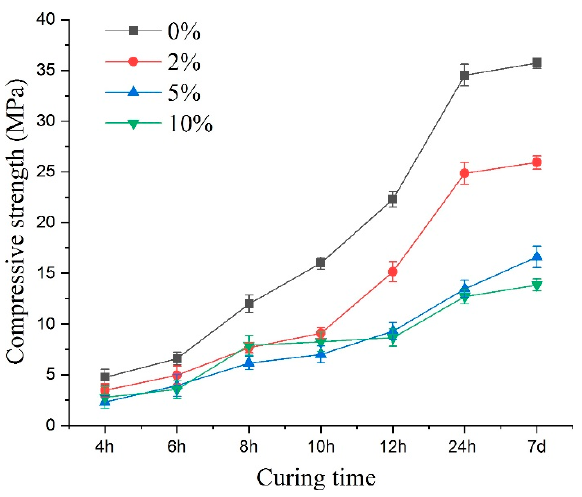
Figure 12. The peak compressive strength of the specimens under sulfate attack with different con- centrations.